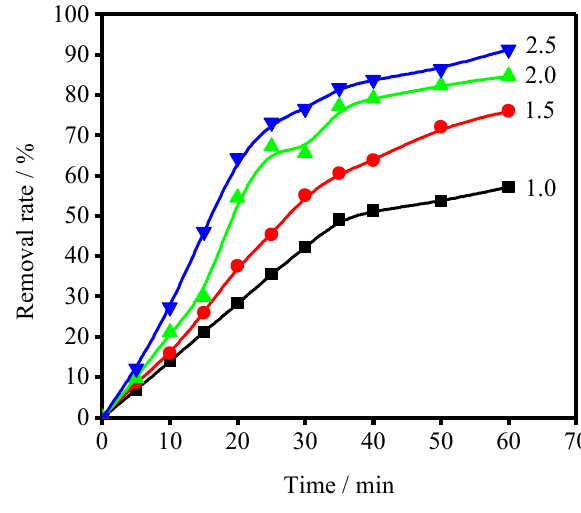
Figure 6. Effect of various NH 4 Cl to EBFS mass ratios on iron removal rate over time Cl to EBFS mass ratios on iron removal Figure 6: Effect of various NH 4 rate over time.